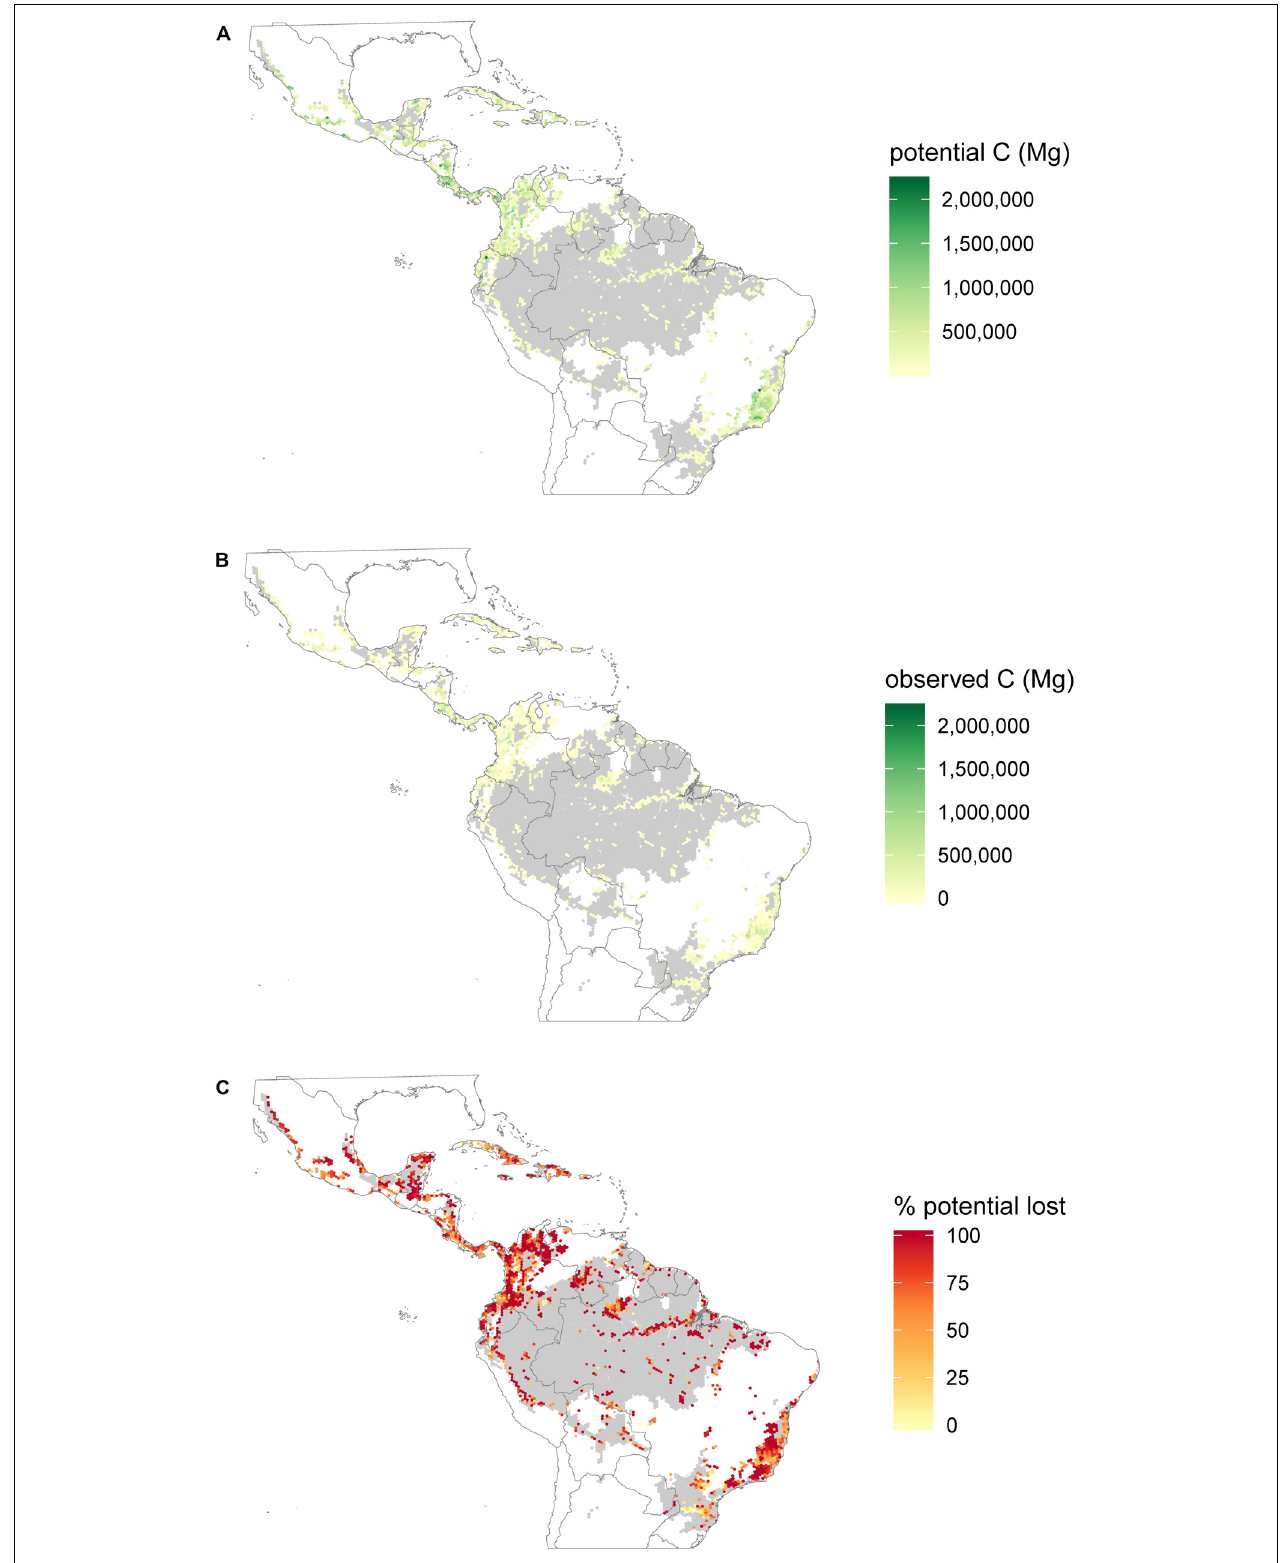
FIGURE 3 | (A) Potential carbon sequestration in new forests, had no re-clearing of reforestation occurred, (B) observed carbon sequestration in new forests, when accounting for re-clearing, and (C) percent of carbon potential foregone due to reversal of reforestation.